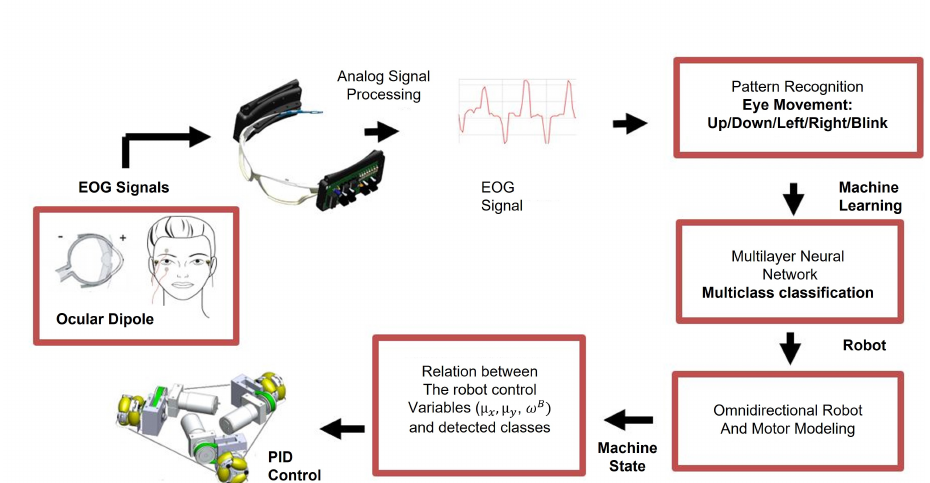
Figure 6. HMI structure. It includes: EOG signal acquisition, signal processing, pattern recognition, multiclass classification, relationship between robot control variables and detected classes, PID control and ominidirectional robot